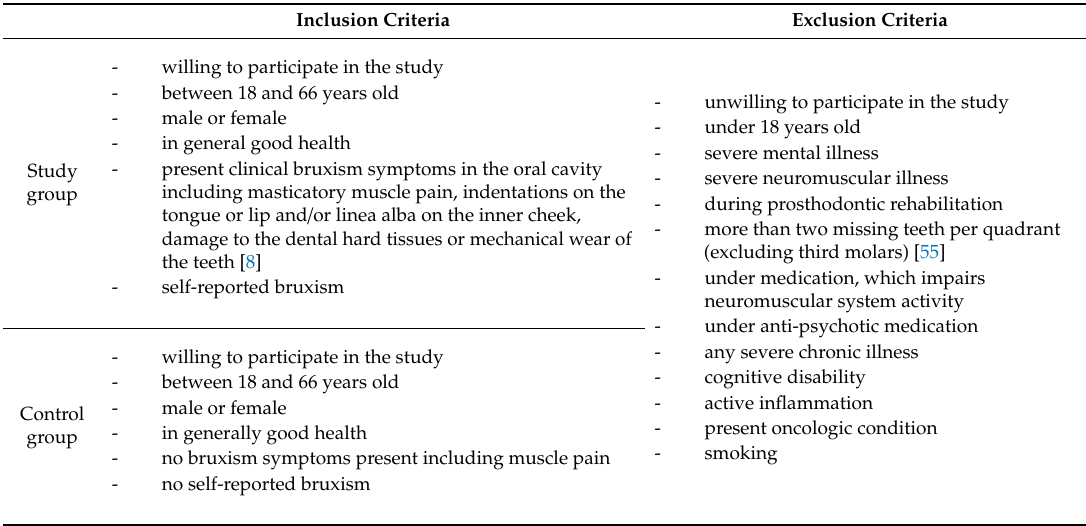
Table 1. Inclusion and exclusion criteria for the study group and the control